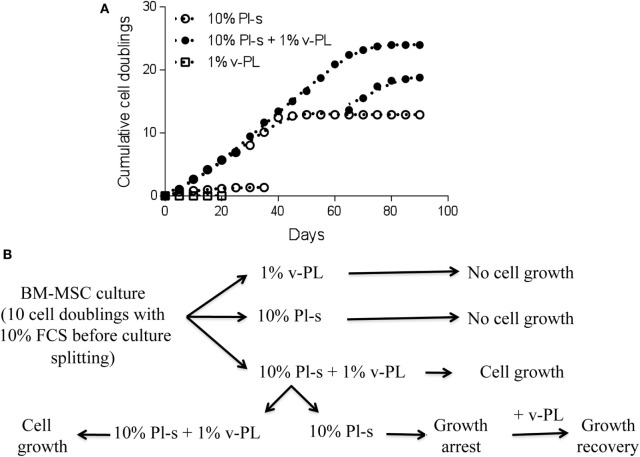
v-PL can rejuvenate a culture of high passage mesenchymal stem cells (MSC). (A) A culture of bone marrow-derived mesenchymal stem cells (BM-MSC) previously expanded in the presence of 10% FCS for about 10 population doublings was split in the different culture conditions. After 3 weeks, one part of the cells of the culture in 10% Pl-s + 1% v-PL was transferred in medium supplemented with Pl-s without v-PL. After additional passages, at a time that proliferation was arrested (high passage cells), part of the Pl-s culture was transferred again in medium supplemented with 10% Pl-s + 1% v-PL (restoring in this way, the v-PL mitogenic stimulus). As shown by the graph, 1% v-PL cannot support cell proliferation, but the addition of v-PL to high passage cells, maintained in the presence of Pl-s as the only supplement, rejuvenate the cells that resume proliferation. (B) A scheme is reported to summarize the experiment in (A).